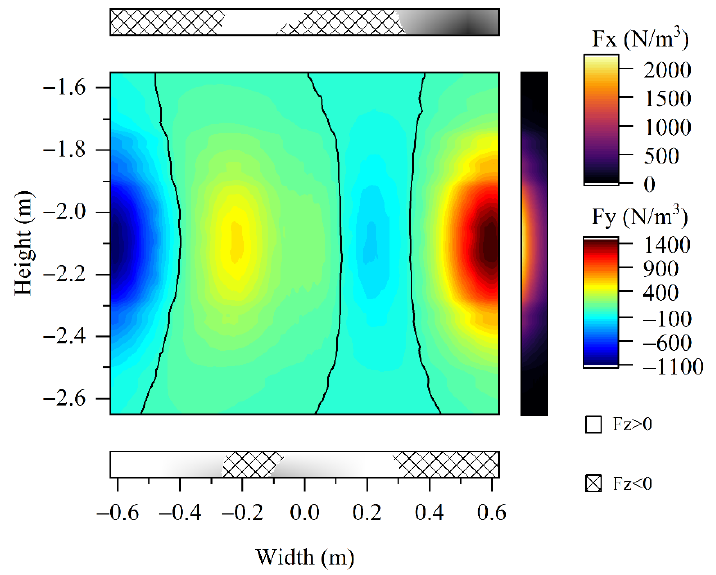
Figure 8. Normal SEMS force in the four planes (Figure 7).